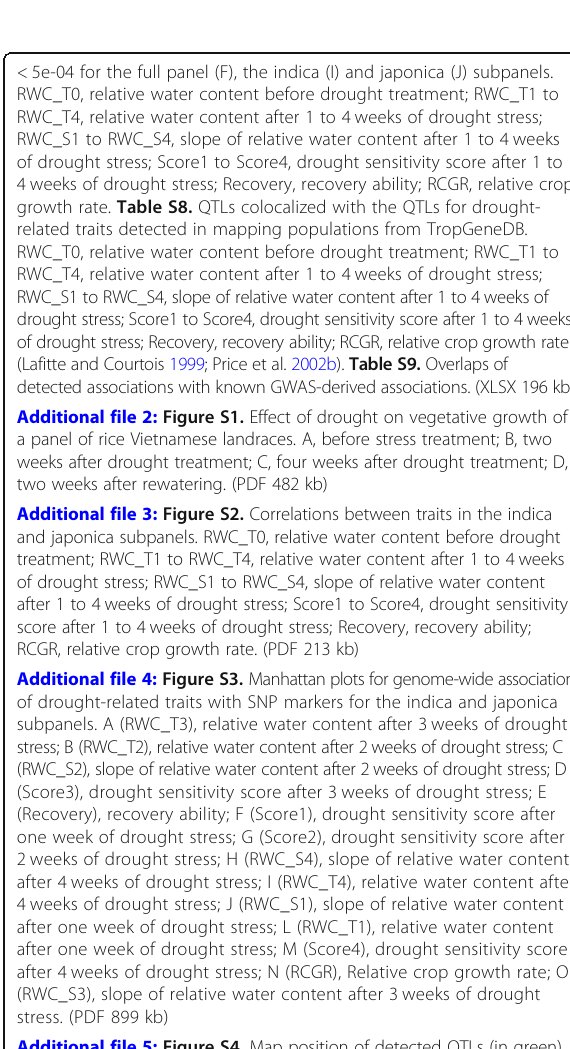
Additional file 5: Figure S4. Map position of detected QTLs (in green) with QTLs for root traits (Phung et al. 2016) (in purple) using the